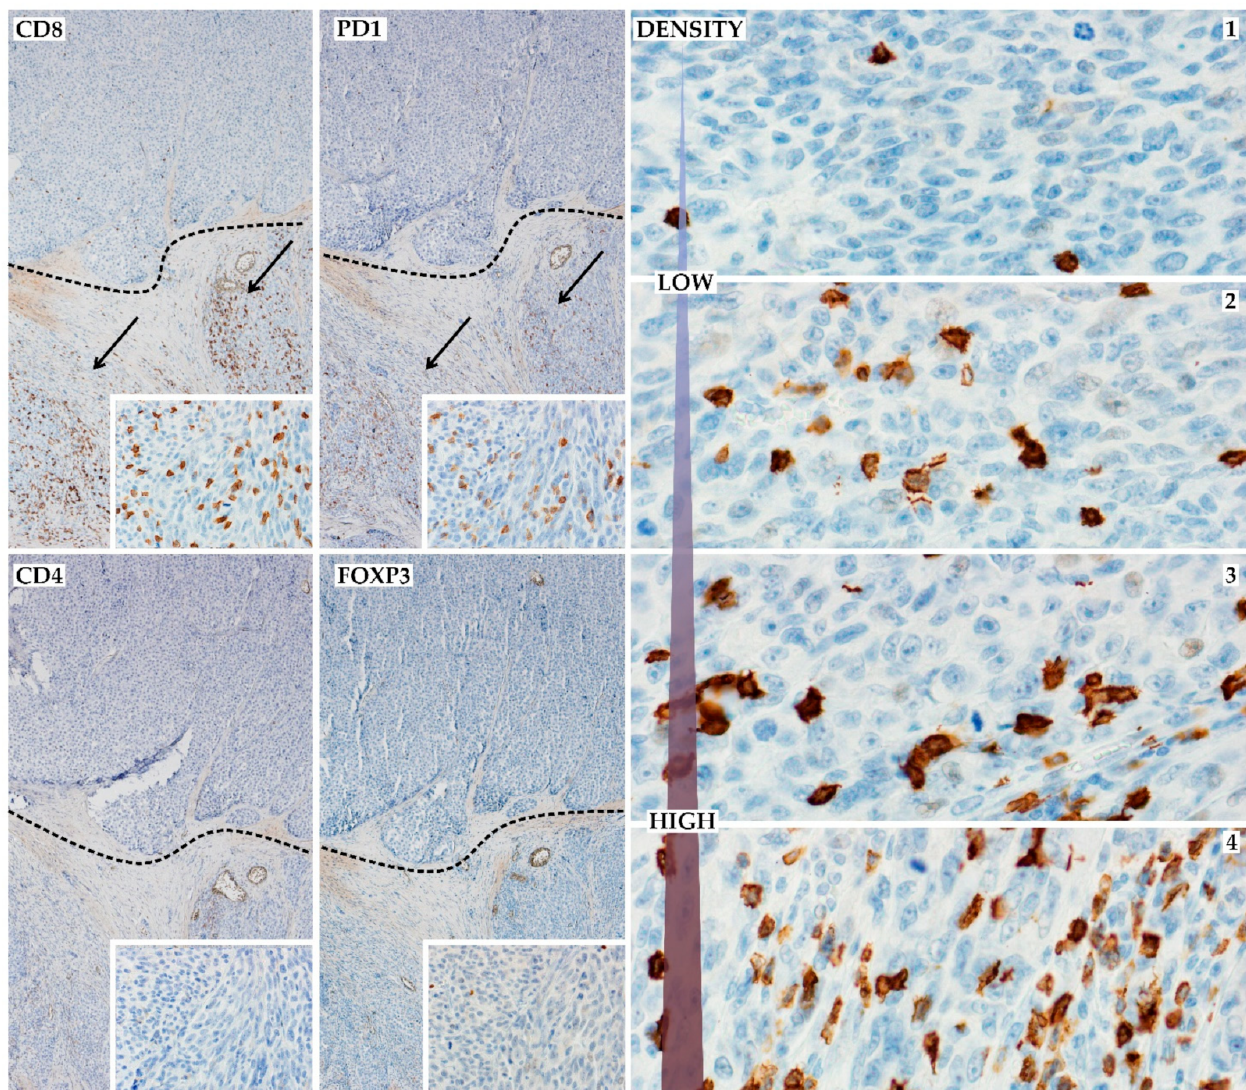
Figure 2. Immunohistochemical assessment of TILs; left panel—the TILs are localized only focally, the upper part of tumor lacks TILs, but the bottom part is characterized by marked TILs with immunophenotype: ( CD8 ) and ( PD1 )-positive cells and without ( CD4 ) and ( FOXP3 ) expression (20 × and 400 × insert photos); right panel—TILs density in high magnification (anti-CD8 antibody, 400 × ), which is a simplified Immunoscore and division into the absent, low (( 1 ) and ( 2 )), or high (( 3 ) and ( 4 )) density of